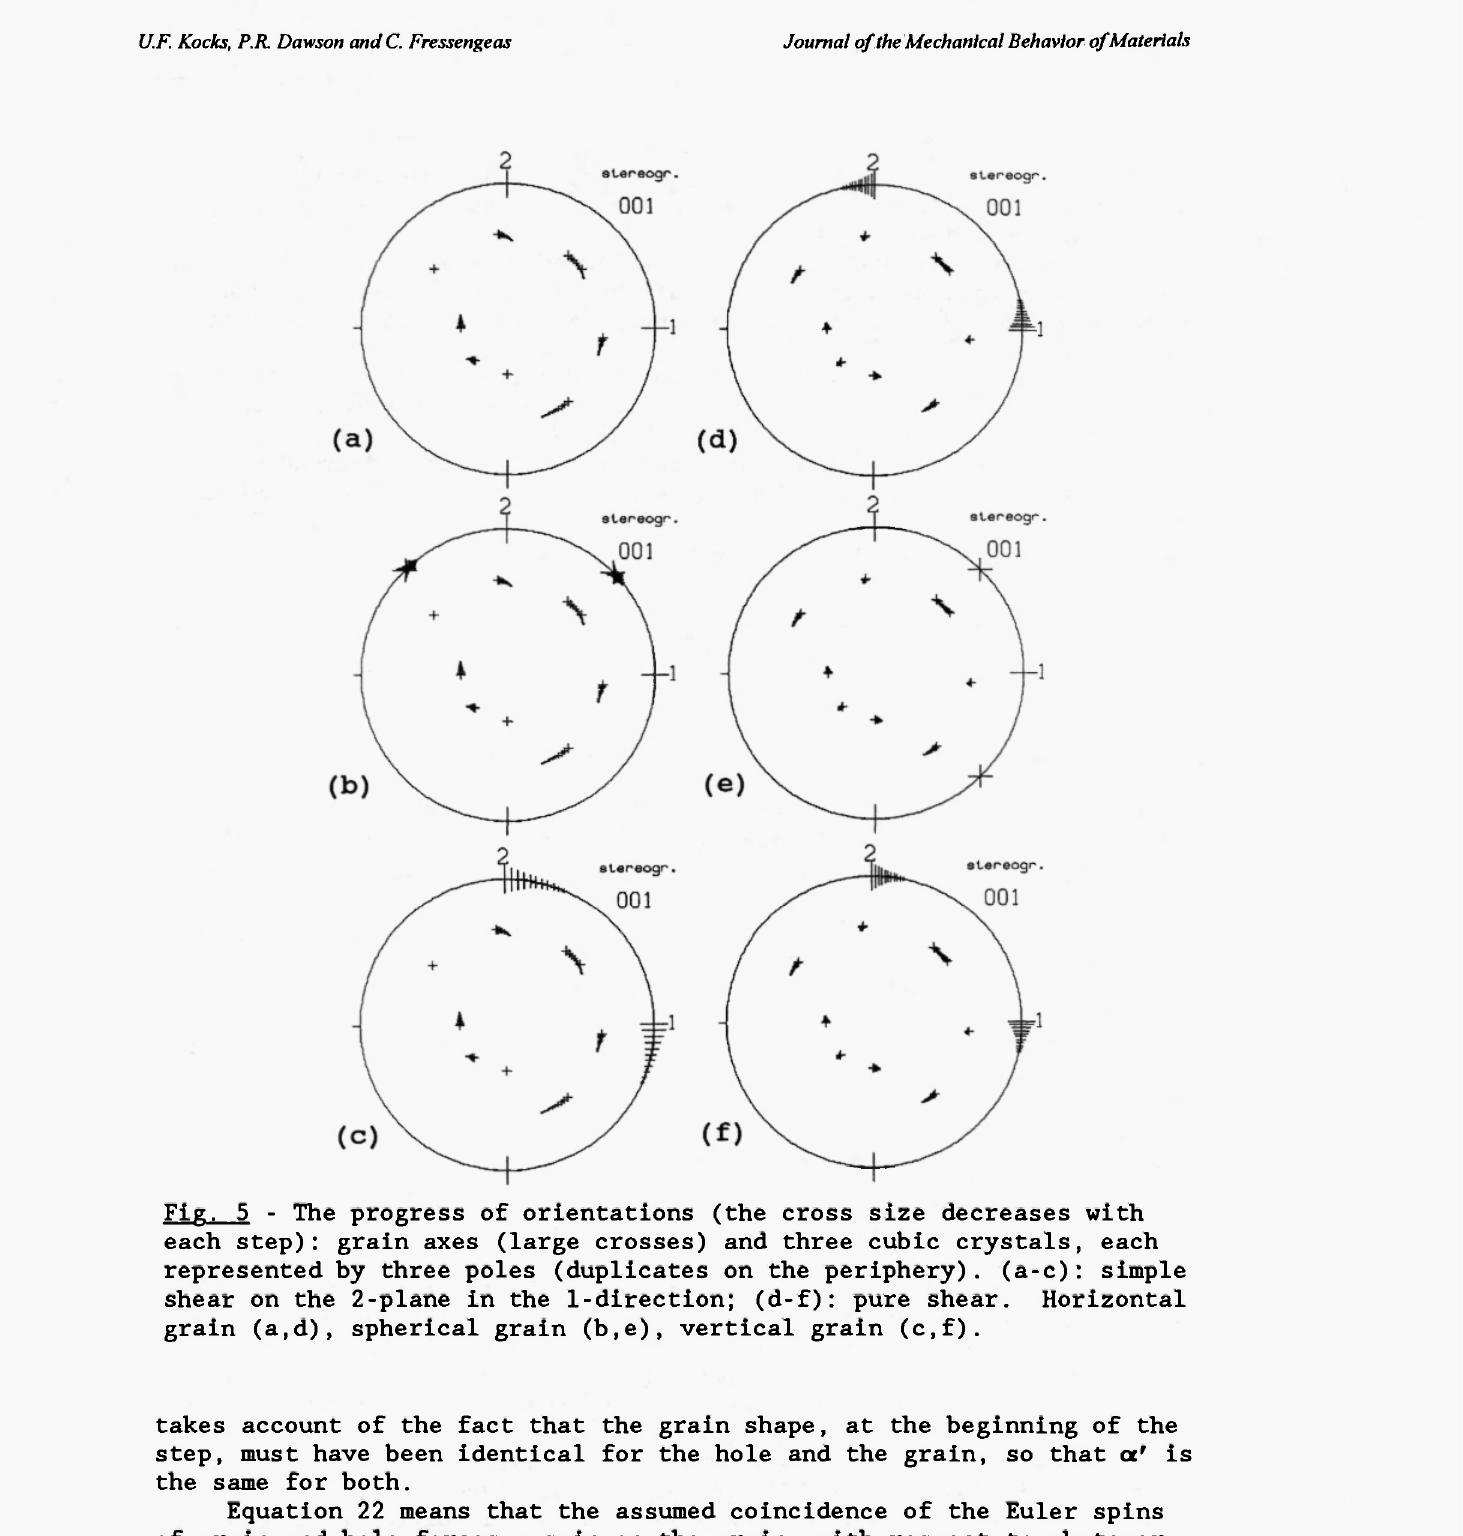
Fig. 5 - The progress of orientations (the cross size decreases with each step): grain axes (large crosses) and three cubic crystals, each represented by three poles (duplicates on the periphery). (a-c): simple shear on the 2-plane in the 1-direction; (d-f): pure shear. Horizontal grain (a,d), spherical grain (b,e), vertical grain